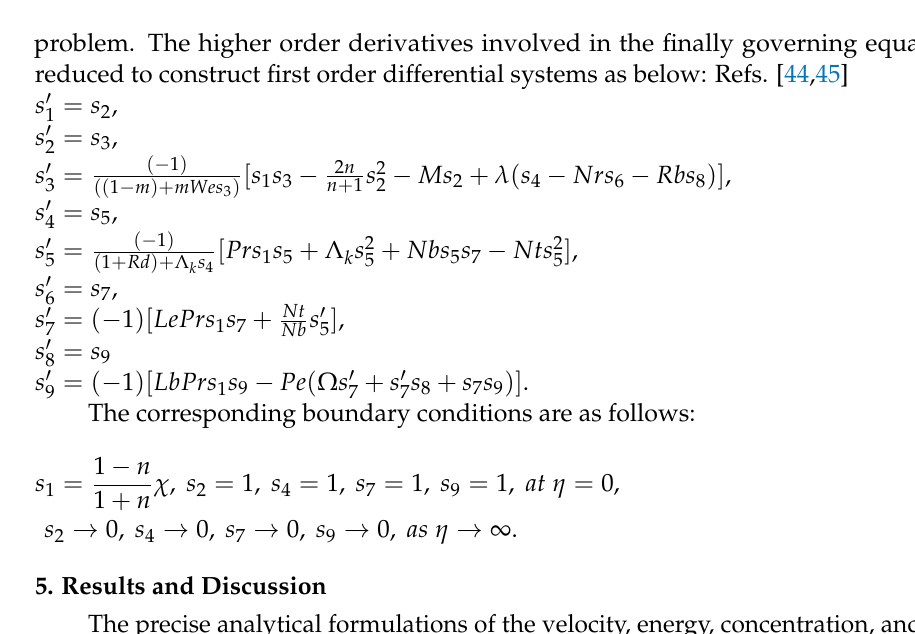
Table 1. Comparative of C fx Re